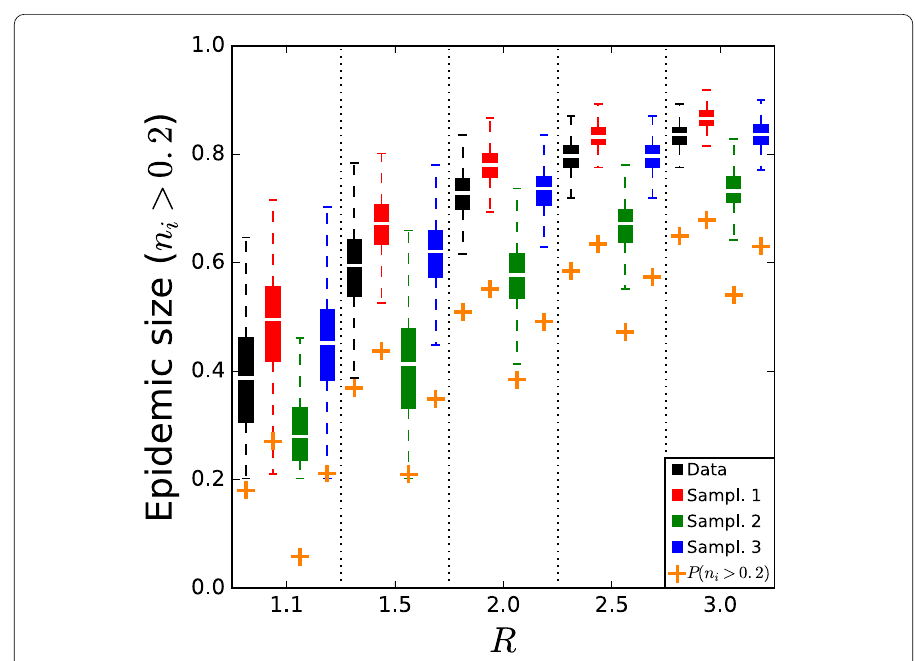
Figure 8 Epidemic prevalence. InVS15 data set. We plot the fraction of the total number of outbreaks that reach at least 20% of the population (crosses) and the distribution of the sizes of these outbreaks (boxplots) for several values of the reproductive number R , for the original and the surrogate contact